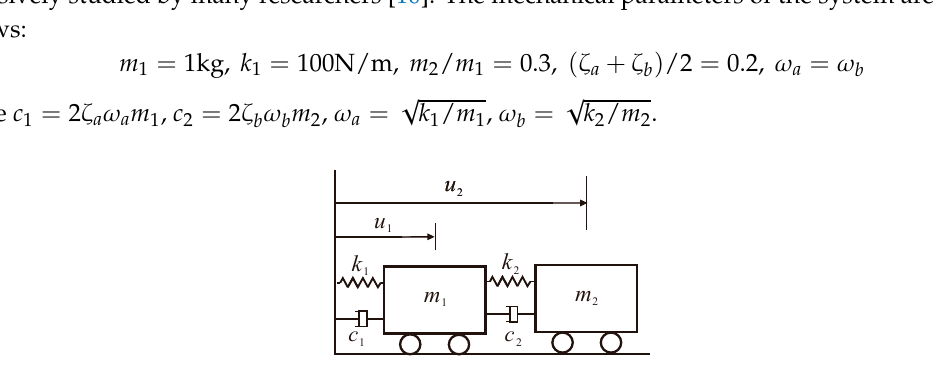
Table 1. The natural frequencies (rad/s) of the 2 DOFs system.